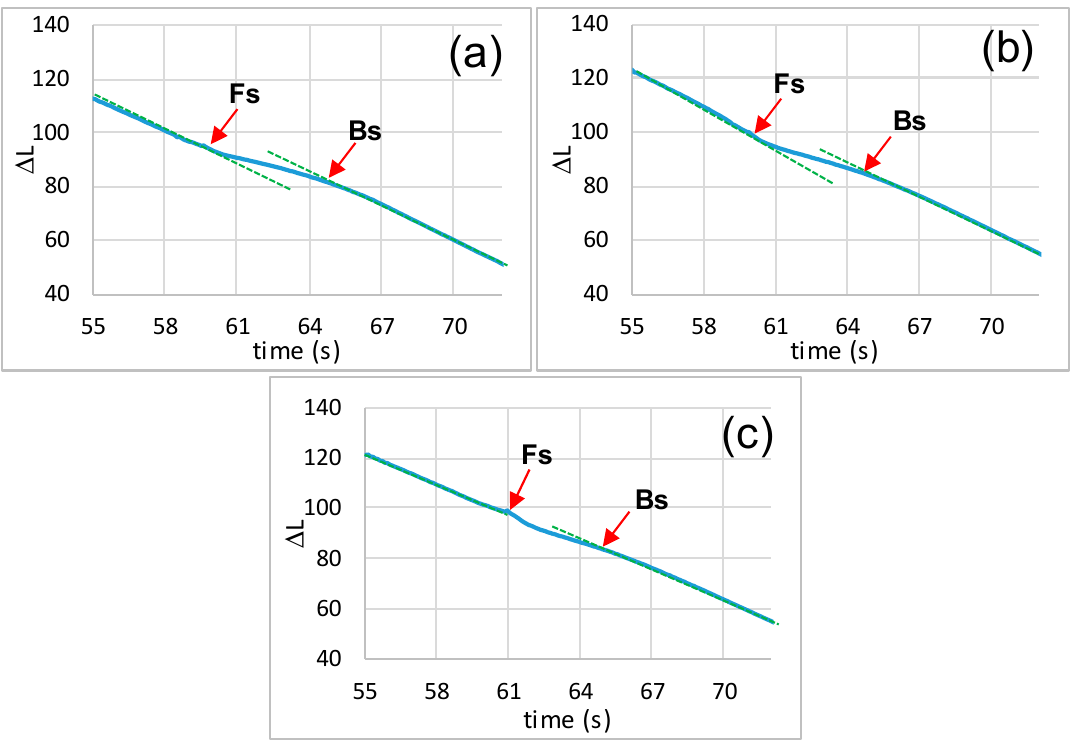
Figure 7. Δ L vs. time curves showing the variation in slope during cooling from annealing to isothermal bainitic treatment conducted at: ( a ) 425 °C; ( b ) 450 °C, and ( c ) 475 °C.